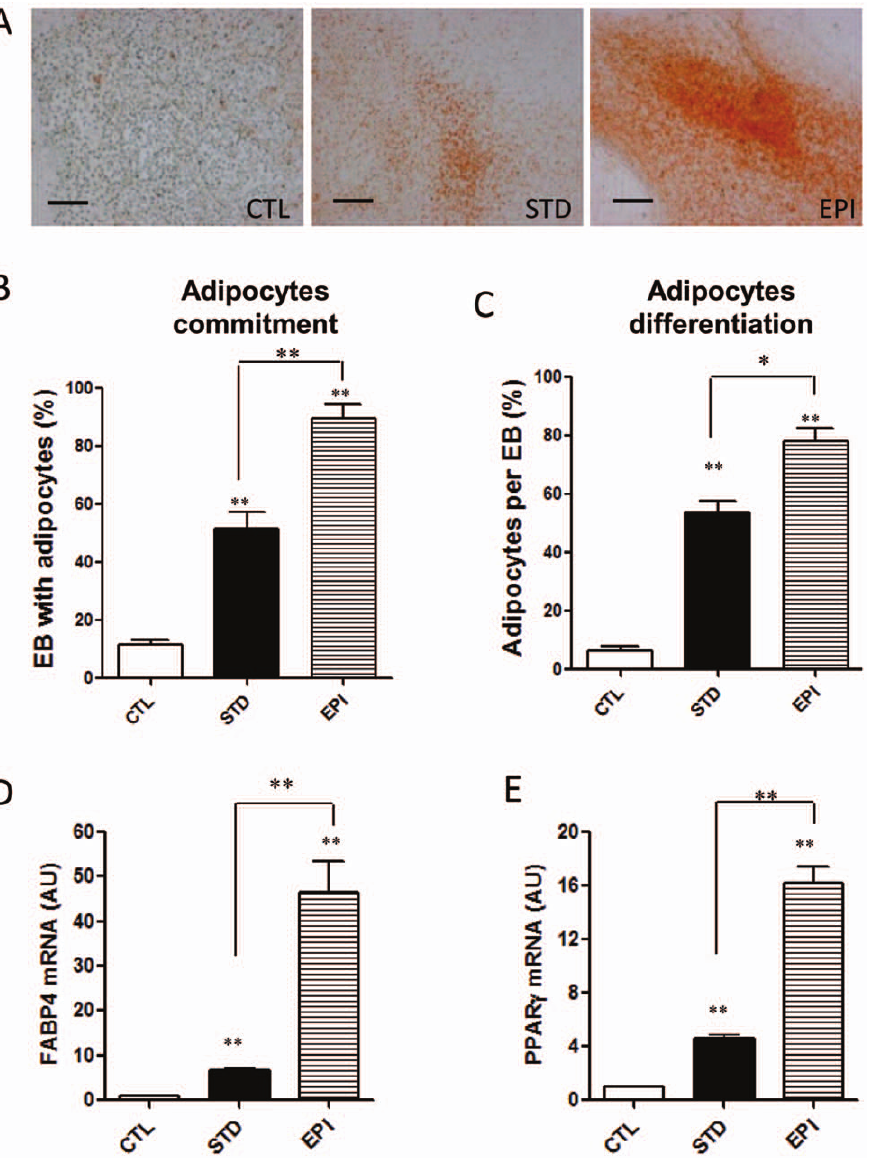
Figure 2. Epinephrine augmented and accelerated the differentiation of mESCs into adipocytes at the end of differentiation. (A) Images of adipocytes developed from EBs treated without insulin at the end of differentiation (day 27) (CTL), with insulin (STD) or insulin plus epinephrine (EPI) added from day 7 to day 17 during commitment stage. Scale bars=150 m m. (B) Percentage of EB outgrowths with adipocyte colonies and (C) percentage of adipocytes per EB outgrowth were measured and quantified at day 27. (D–E) Gene expression of adipocyte markers was measured by real time PCR at the end of the differentiation (day 27). RNA was isolated from differentiated mESCs and analyzed for expression of adipocyte marker genes FABP4 and PPAR c . b -actin expression was used as an internal control. Values are from three separate experiments each performed in triplicate. *p , 0.05, **p , 0.01.